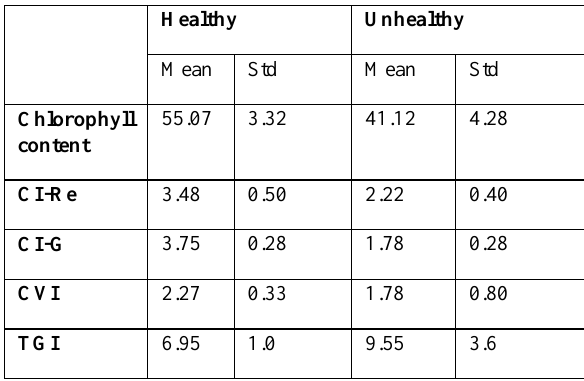
Table 1: The mean and standard deviation (Std) calculated for the leaves samples collected from 5 healthy ash trees and 3 unhealthy